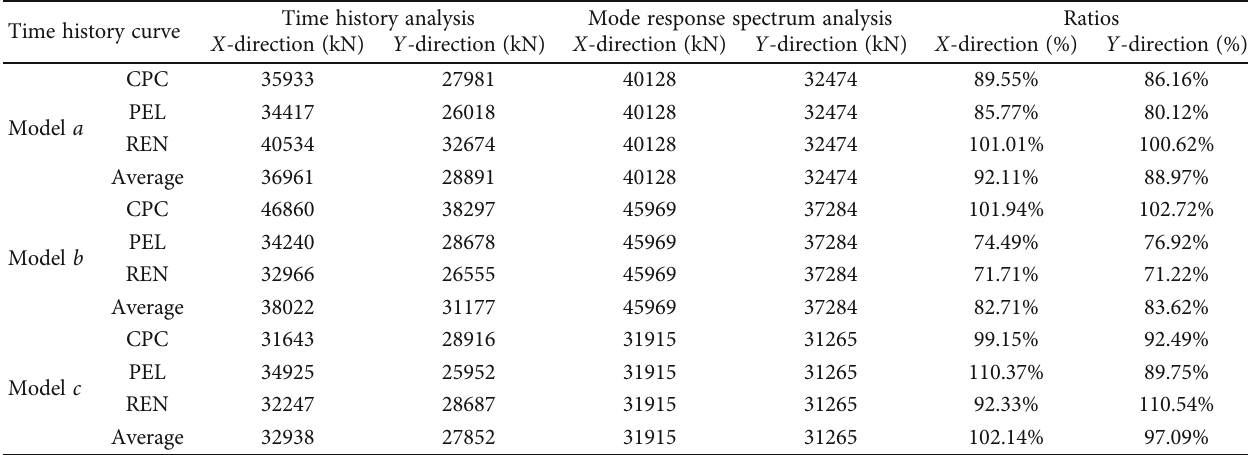
Table 1: Comparison table of base shear values.